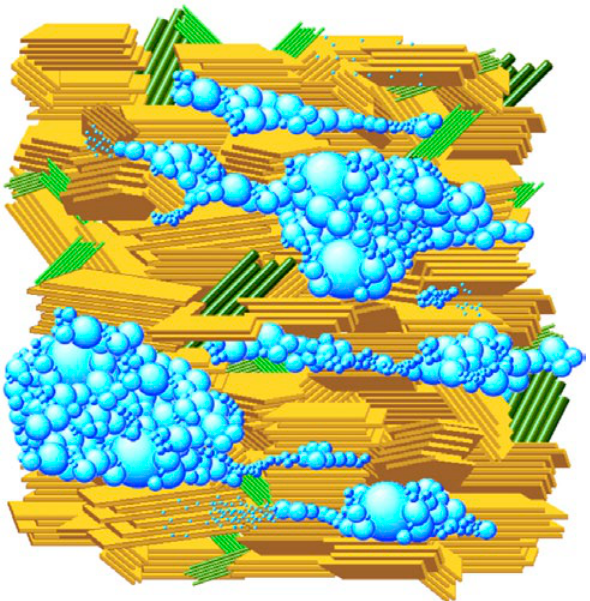
Figure 14. With continued laminar flow the micro-aggregates of silica spheres combine to form larger macro accretions that survive in the shear regime in accordance with their internal cohesion. This is dependent on their ‘purity’, the degree to which they have been “kneaded” (broken and re-formed) in the laminar flow (From Elli- ston 9 , 2017, p.101).